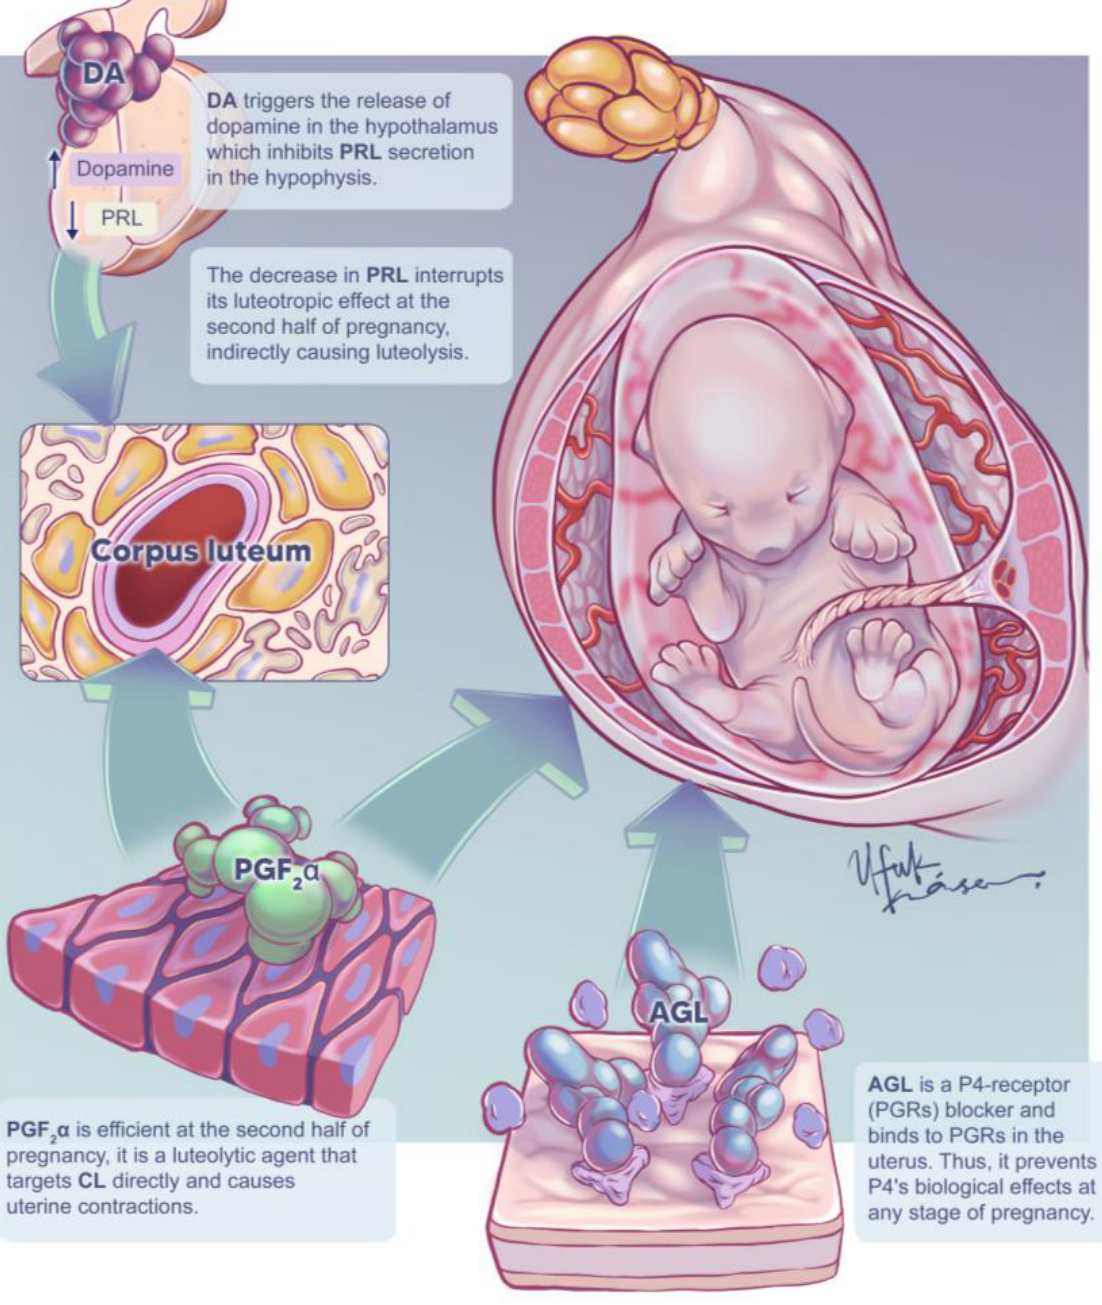
Figure 1. Summary of the abortifacient mechanism of action of PGF 2 α , dopamine agonists (DAs), and aglepristone (AGL).